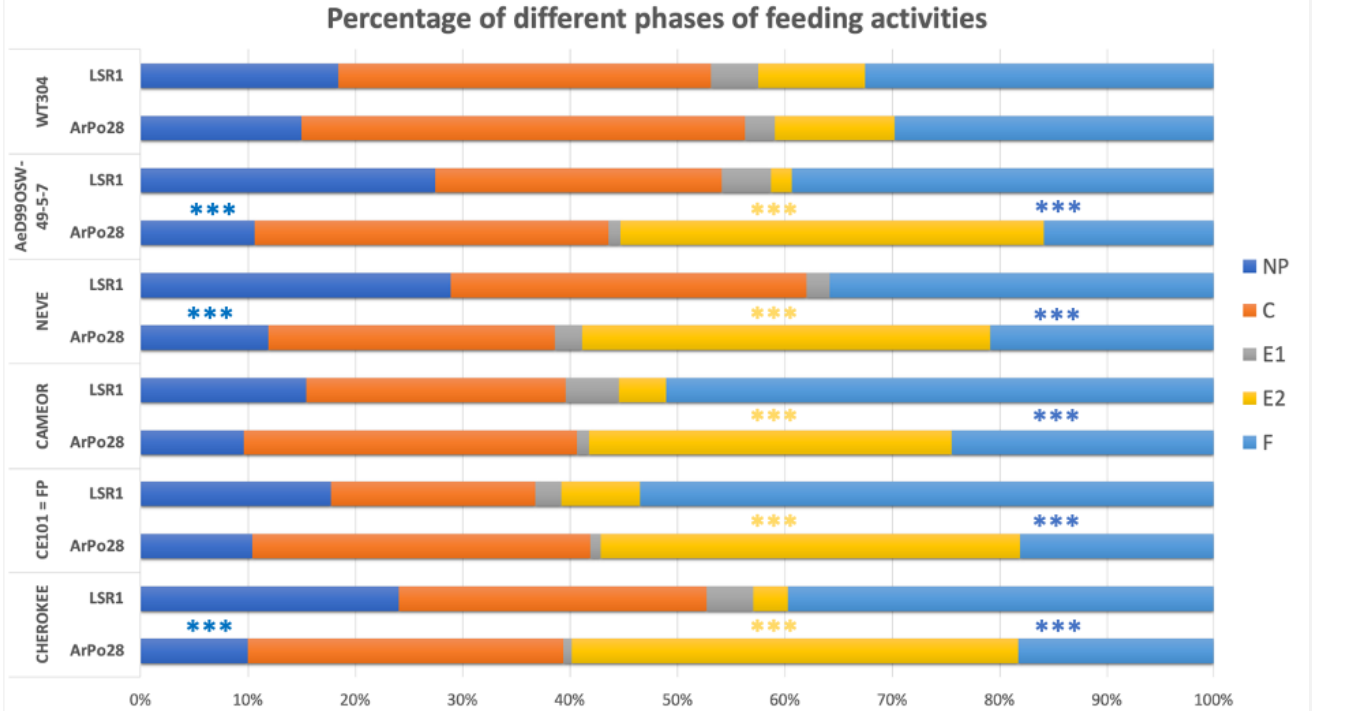
Figure 5. Percentage of the different phases of feeding activities during 8 h EPG recordings of pea biotype (ArPo28) and alfalfa biotype (LSR1) on P. fulvum (WT304) and on the different P. sativum genotypes (NP, non-probing; C, pathway; E1, phloem salivation; E2, phloem sap ingestion; F, derailment). Pairwise comparisons using Wilcoxon rank sum test with continuity correction were carried out (Mann – Whitney U test) and asterisks indicate a significant difference, *** p < 0.001.